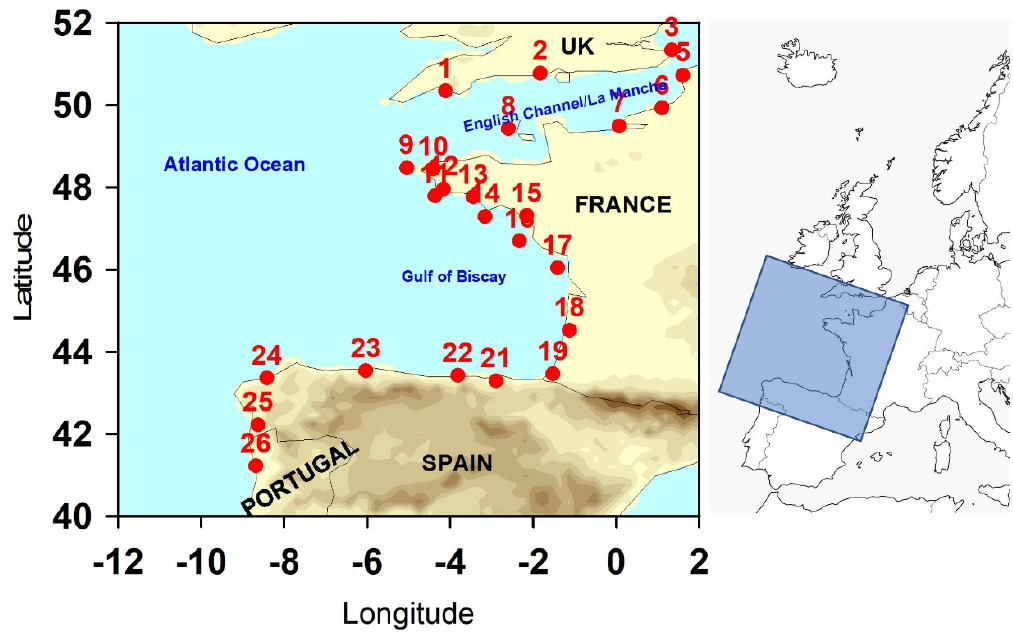
Figure 1. Location of the study area. Extended information about stations identified with red numbers appear in Appendix A.